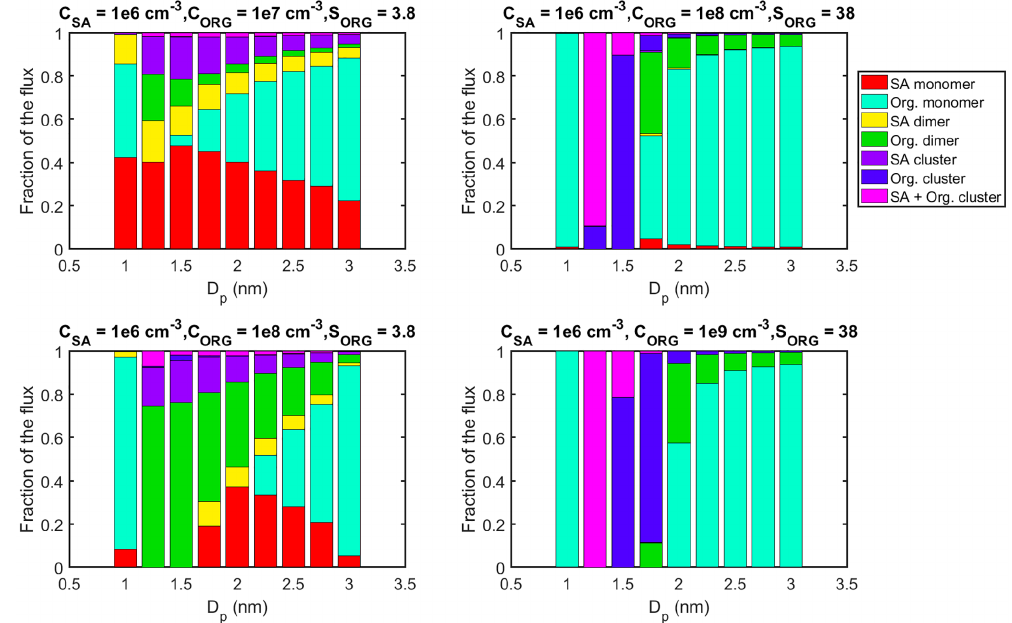
Figure A2. Contribution of different vapor monomers and clusters to the net flux past different threshold sizes in simulations with SA–DMA and an organic compound (ORG). The vapor concentrations and the saturation ratio of the organic compound ( S ORG ) are shown above the figures for each simulation. The values are at steady